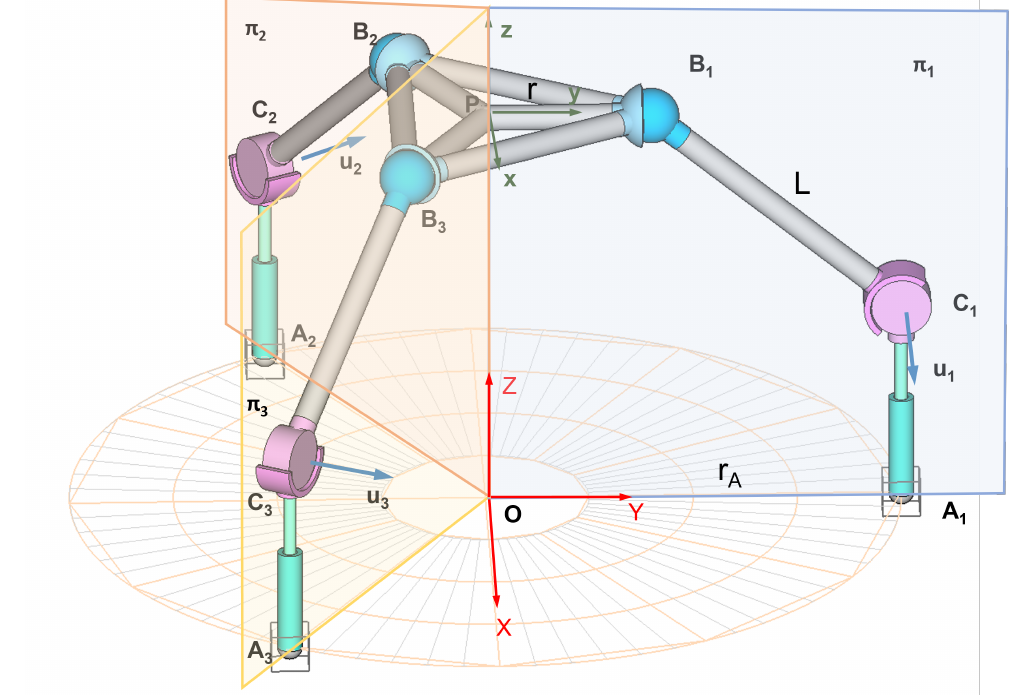
Figure 1. Rigid tripod: 3 PRS parallel kinematics